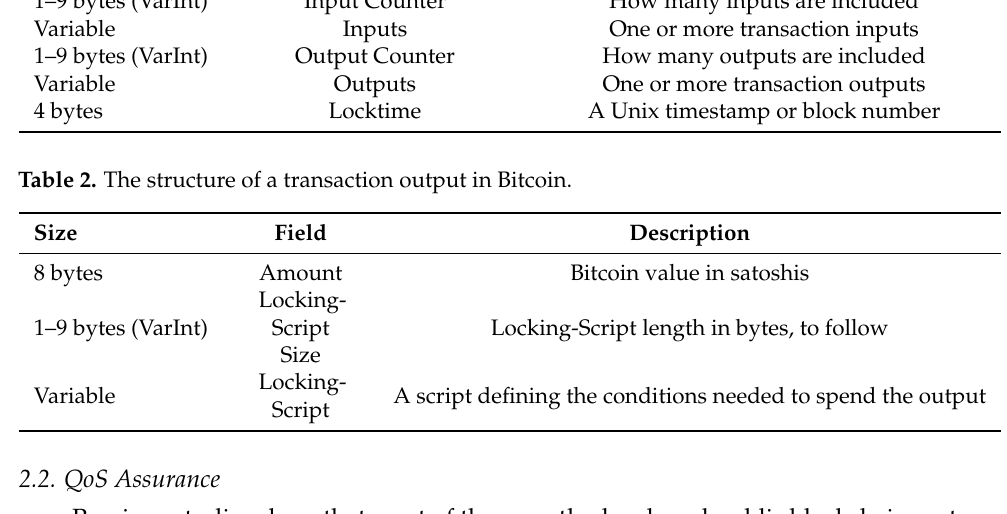
Table 1. The structure of a transaction in Bitcoin. Field Description Version